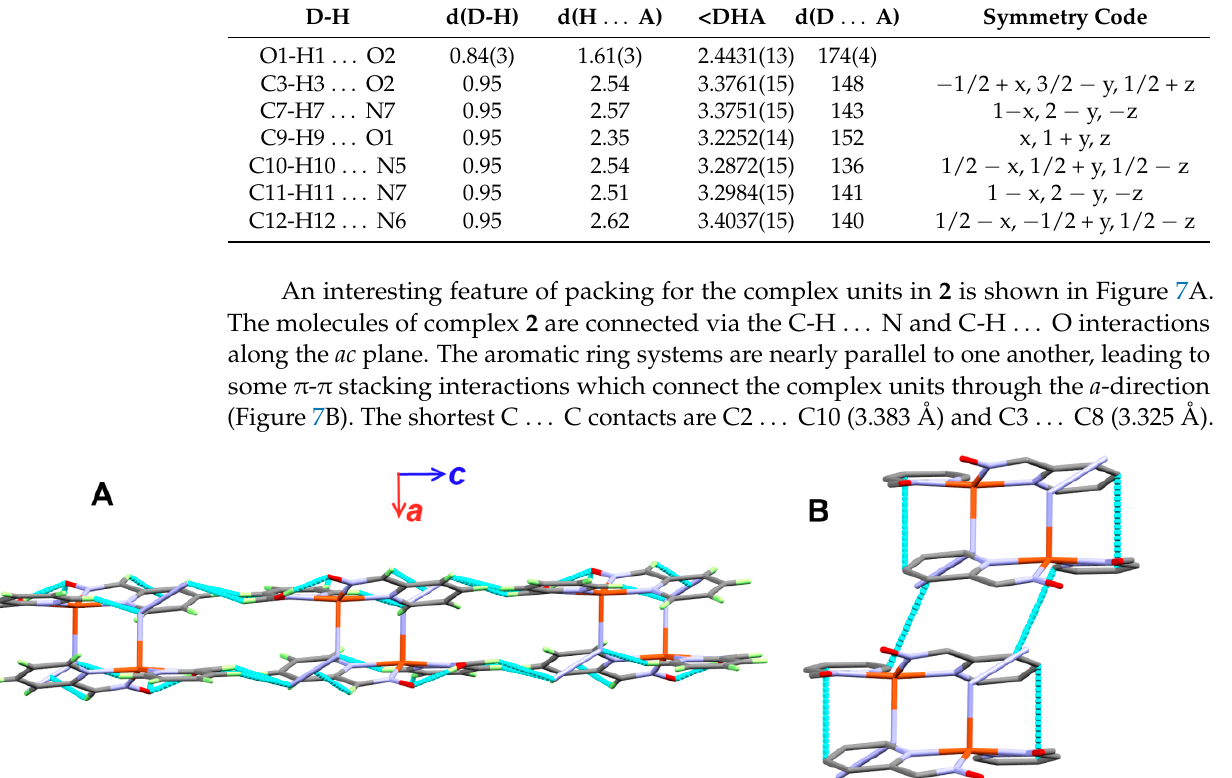
Figure 7. Packing scheme of 2 along the monoclinic b -axis ( A ) and π - π stacking interactions extended through the a -direction ( B ). Hydrogen atoms are omitted in both projections.